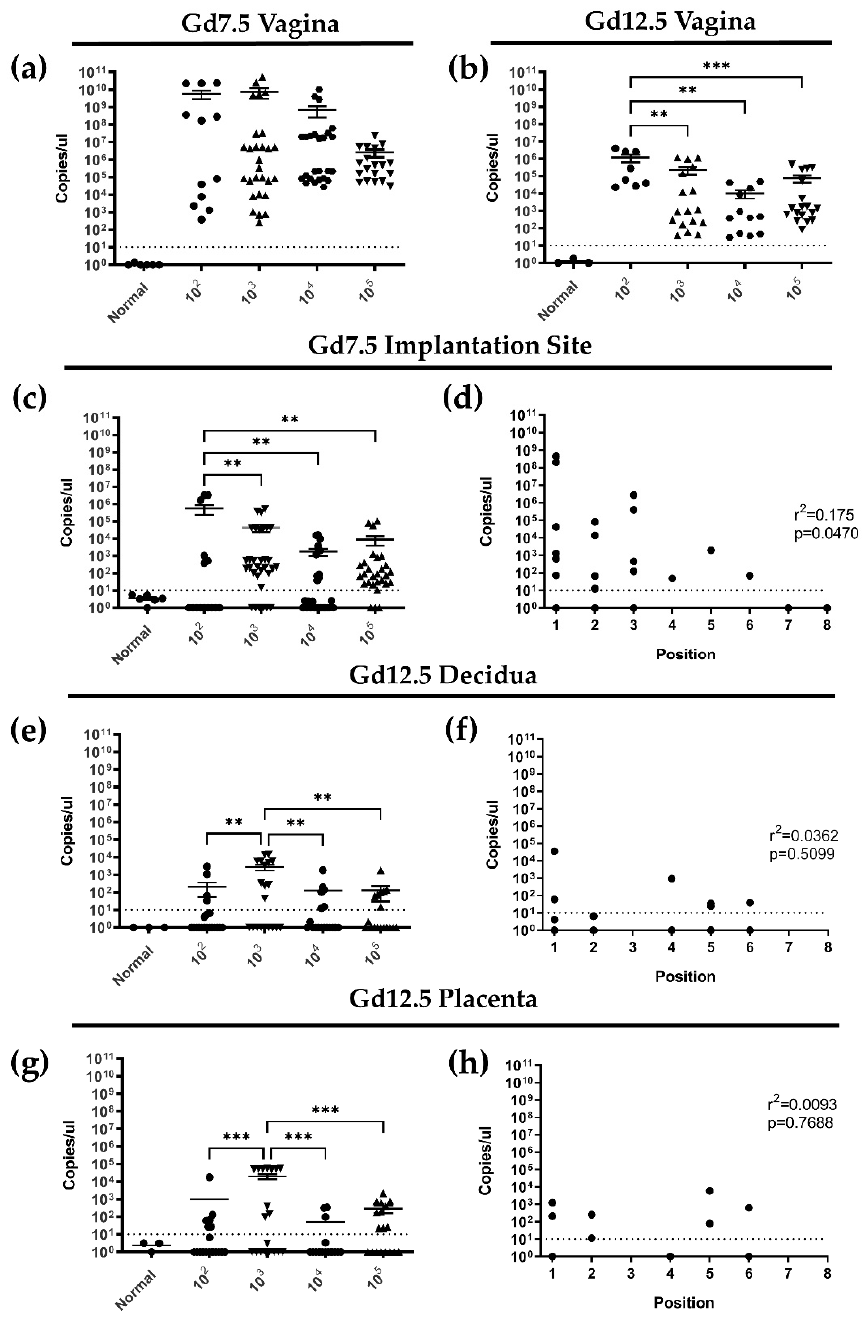
Figure 3. HSV-2 is detected in the vaginal tract by qPCR, ascends directionally into gd7.5 implantation sites, and persists in placental tissues 8 days post infection (dpi). ( a ) Quantification of HSV-2 DNA by qPCR revealed high viral loads within vaginal tissue at gd7.5 with all viral doses. ( b ) HSV-2 DNA persisted in vaginal tissue collected at gd12.5 but was detected at lower quantities than at gd7.5. ( c ) Quantification of HSV-2 DNA in gd7.5 implantation sites by qPCR. ( d ) HSV-2 viral load in gd7.5 implantation sites is dependent on location along the uterine horn, with higher copy numbers detected in implantation sites close to the cervix (position 1) as compared to those close to the ovary (position 8). ( e ) Quantification of HSV-2 DNA by qPCR in the decidua at gd12.5. ( f ) At gd12.5, HSV-2 viral load in the decidua is independent of implantation site position along the uterine horn. ( g ) Quantification of HSV-2 DNA by qPCR in the placenta at gd12.5. ( h ) HSV-2 viral load in the placenta is independent of implantation site position along the uterine horn. Data expressed as mean ± SEM. ** p < 0.01, *** p < 0.001.